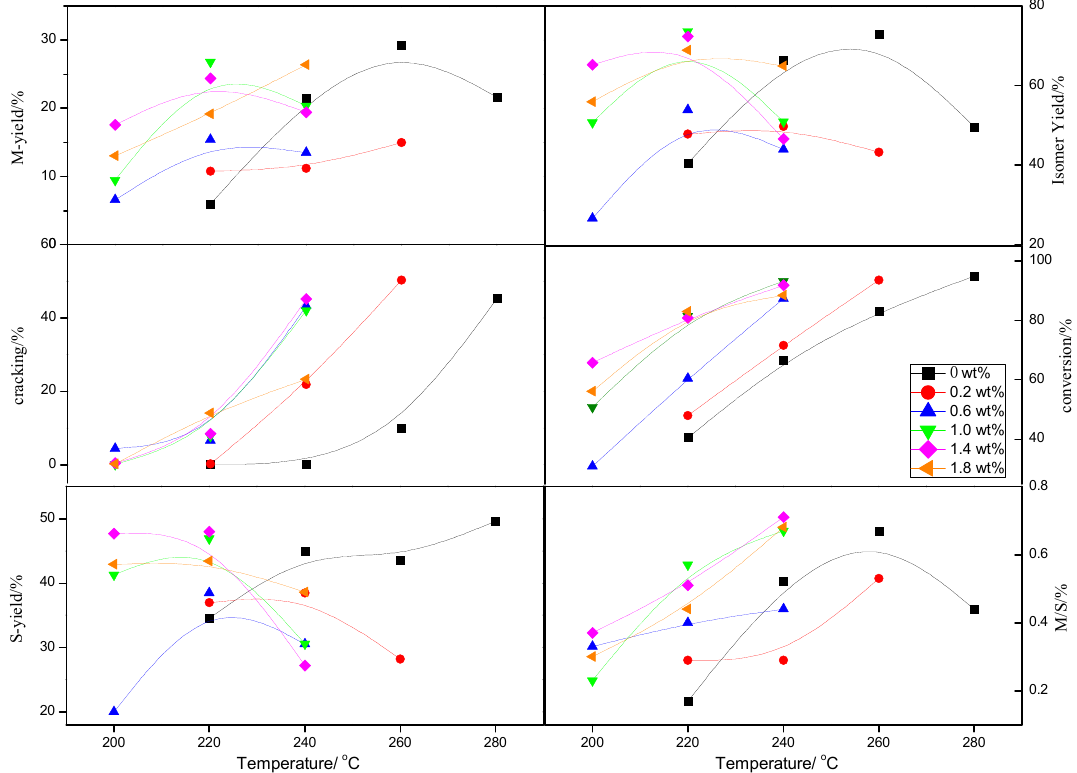
Figure 3. The activity of Cr-Pt/WZ catalysts with different Cr content. Reaction condition: n(H 2 ):n(C 7 ) = 9 mol/mol, LHSV(liquid hourly space velocity) = 0.7 h − 1 , and P = 1.0 MPa, T = 200~280 °C. S-Yield: Single-chain isomer yield, M-Yield: Multi-branched isomer yield, M/S: M-Yield/ S-Yield.